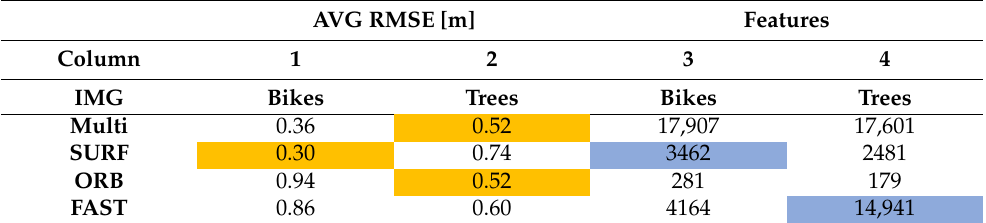
Table 3. Bike and trees average RMSE [m] and the average number of features detected. AVG RMSE [m]